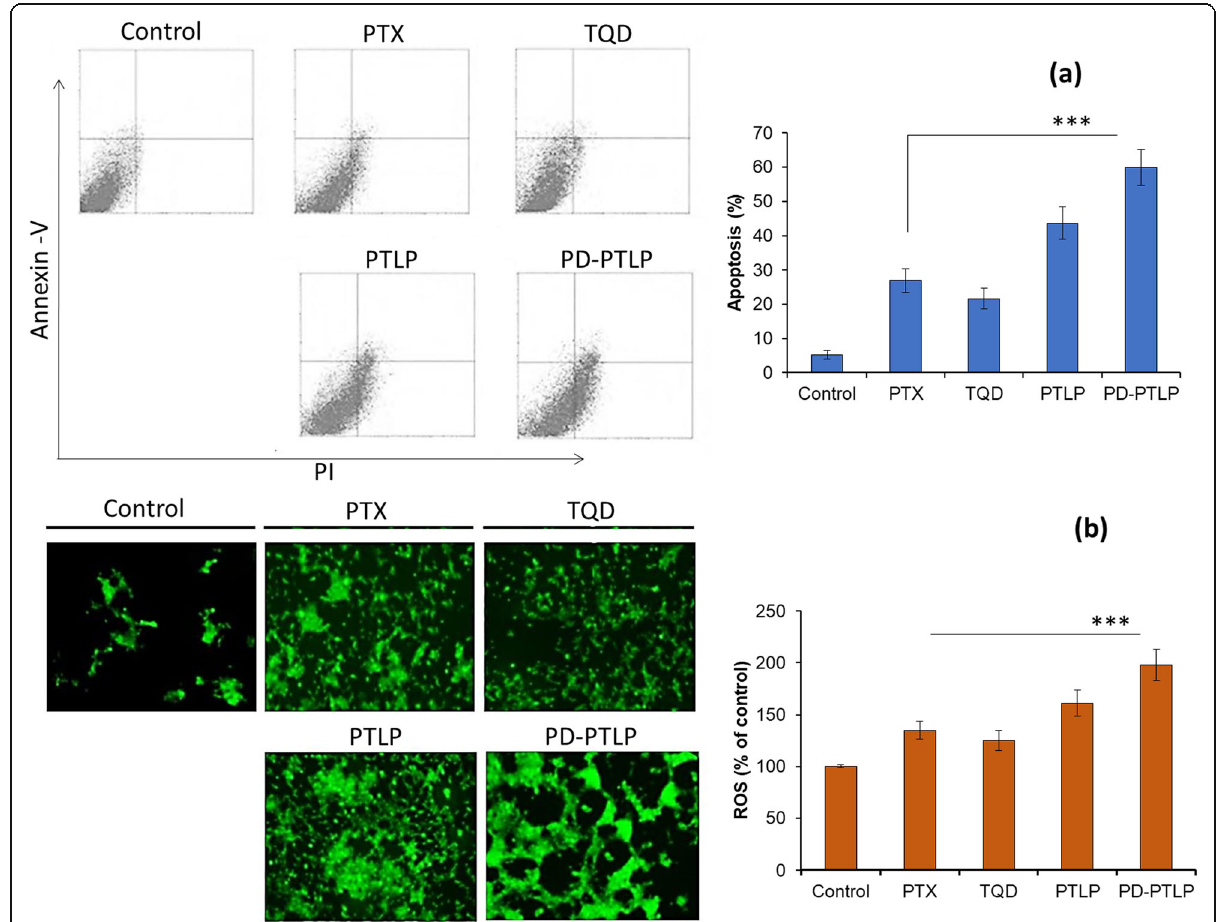
Fig. 5 a Apoptosis assay of SGC7901/ADR cells after staining with Annexin V/PI combo using flow cytometer. The cells were treated with a fixed concentration of 2 μ g/ml. b Reactive oxygen species (ROS) analysis of SGC7901/ADR cells using 2,7-dichlorofluorescin diacetate (DCFH-DA) as a probe. *** p < 0.001 is the statistical difference between free PTX and PD-PTLP-treated